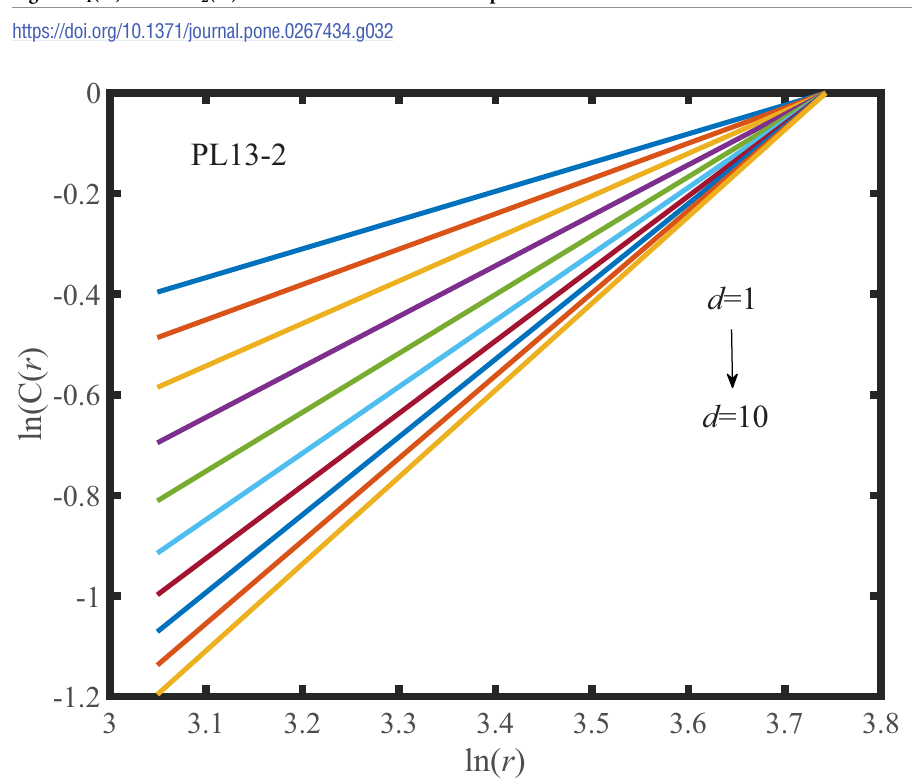
Fig 33. Double logarithmic curve of correlation dimension of the